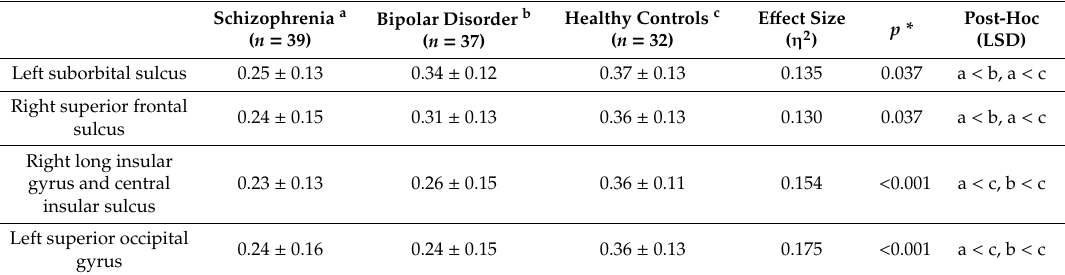
Table 3. Mean and standard deviation values of clustering coe ffi cients at the nodal level for the schizophrenia, bipolar disorder and healthy control groups.